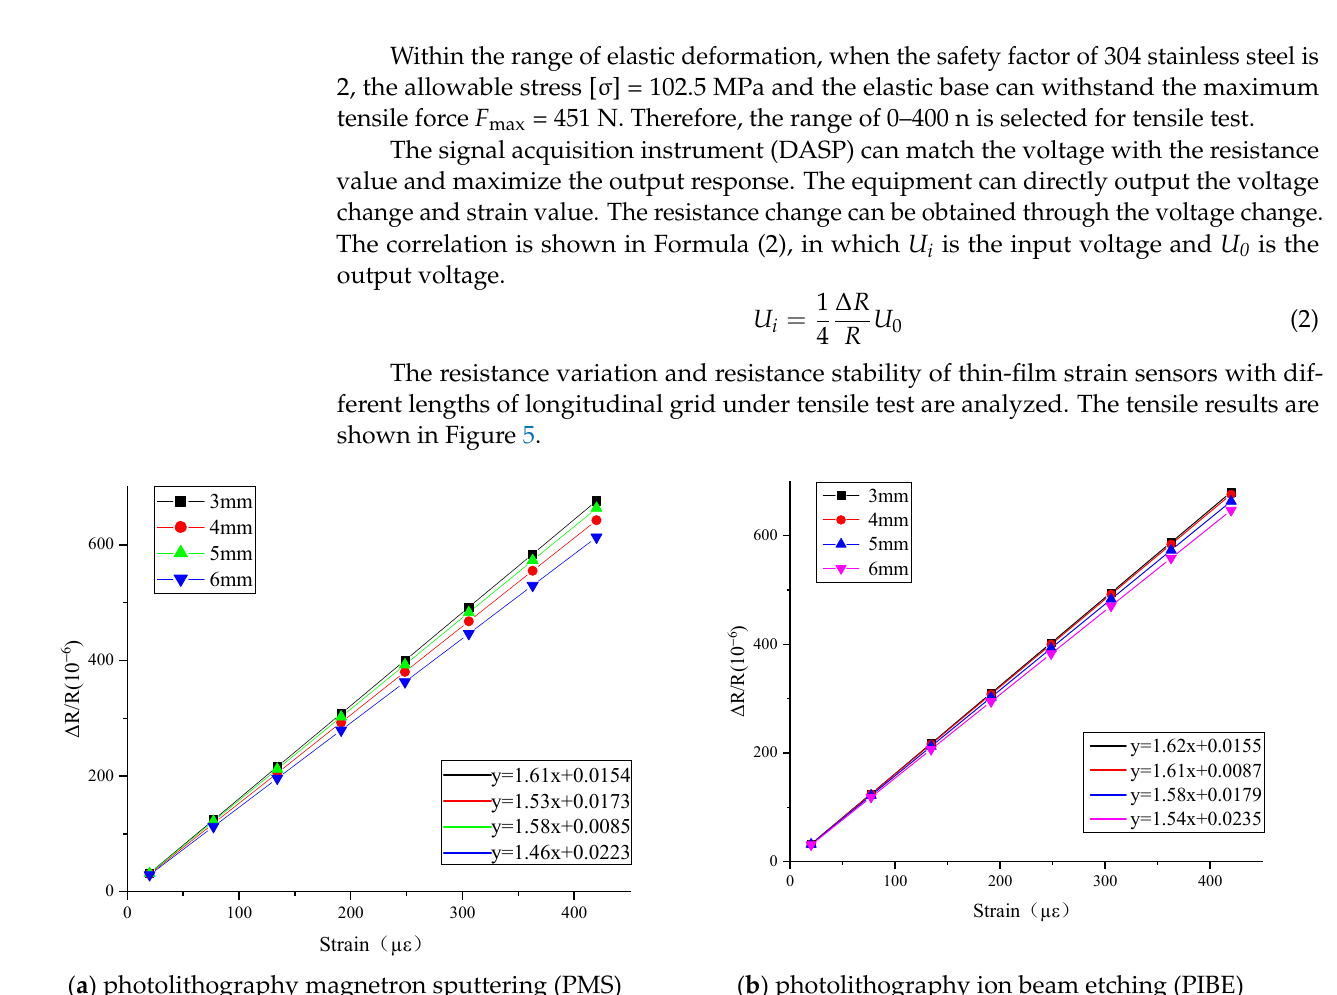
5 of 18 Figure 4. Thin-film resistance grid tensile test diagram. According to the tensile strain, the theoretical tensile strain of the elastic substrate of the thin-film sensor is calculated by Equation (1).